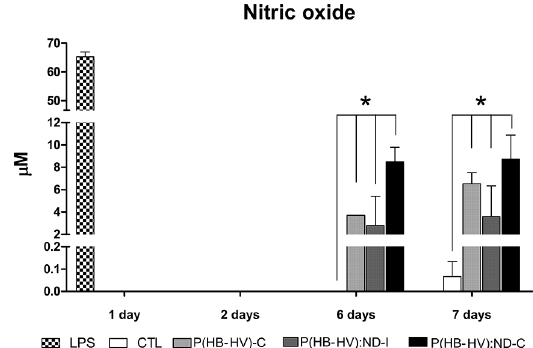
Figure 10. Production of nitric oxide by the macrophages in culture with the composites, negative (CTL) and positive control (LPS).